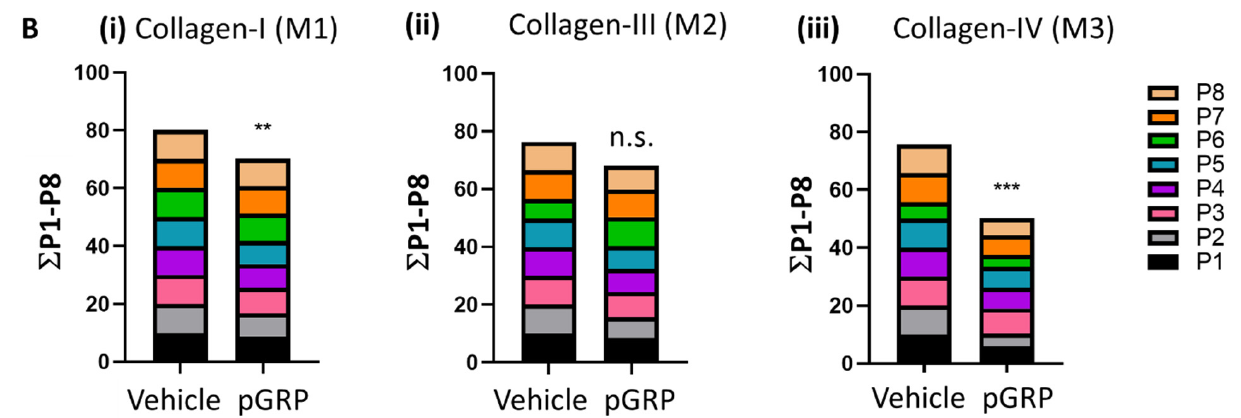
Figure 1. Effect of GPR56 interference on collagen-induced thrombus formation at a high shear rate. Whole blood (700 µ L) was pre-incubated with vehicle medium or pGRP peptide (50 µ g/mL) for 10 min. After recalcification, blood samples were perfused over microspots of collagen I, III, and IV for 3.5 min at wall-shear rate of 1600 s − 1 . Brightfield and fluorescence images were taken per microspot at end stage. ( A ) Shown are representative microscopic images for collagen I of ( i ) vehicle control runs or ( ii ) pGRP runs. Scale bar = 10 µ m. Complementary images for thrombi on collagen III and collagen IV are shown in Figure S1. ( B ) Cumulative plots per condition of scaled (0–10) image parameters: P1, platelet adhesion; P2, platelet aggregate coverage; P3–5, thrombus morphology, multilayer and contraction scores; platelet activation markers: P6, PS exposure; P7, P-selectin expression; P8, fibrinogen binding (see Table 1). Shown are means of duplicate runs for three donors. Mean values ± SD (n = 3); n.s., not significant, ** p < 0.005, *** p < 0.001 vs. vehicle (paired Student’s t